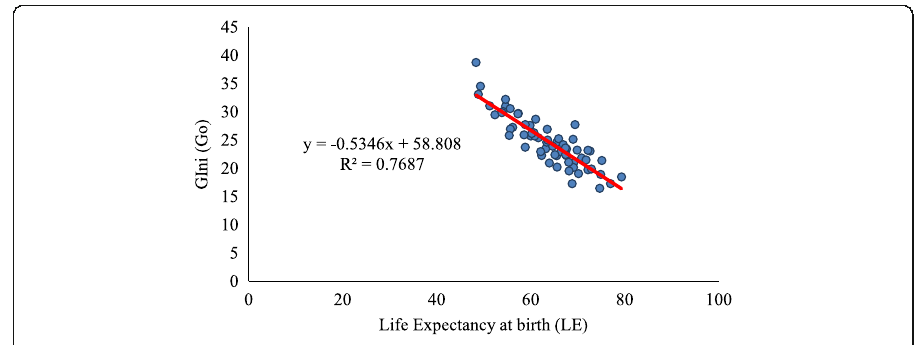
Fig. 2 Relationship between life expectancy at birth and Gini coefficient, India, women